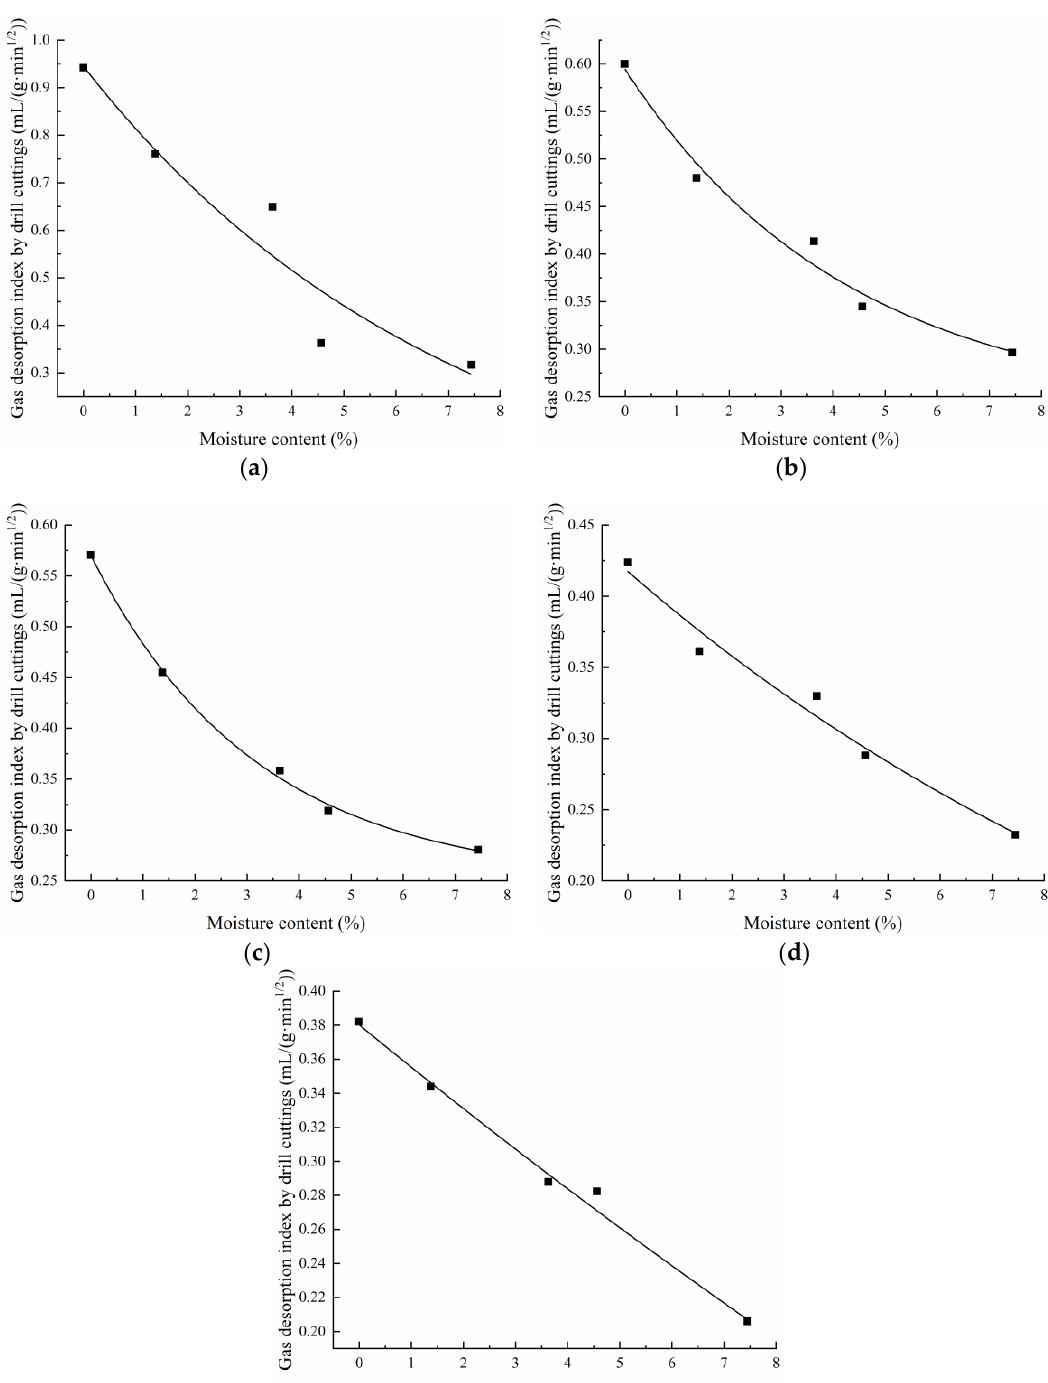
Figure 7. The index K 1 under diverse water content and depressurization desorption conditions. ( a ) Desorption stage: 0.5 MPa–0 MPa. ( b ) Desorption stage: 1 MPa–0.5 MPa. ( c ) Desorption stage: